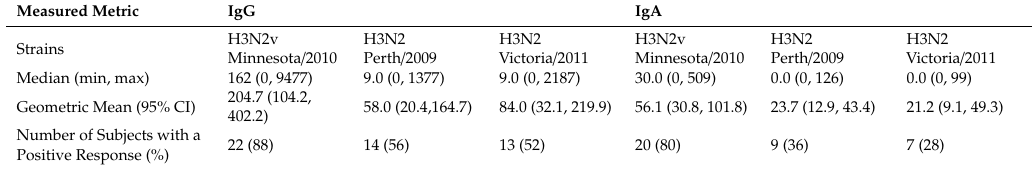
Table 3. Influenza strain-specific plasmablasts 1 per million PBMCs at Day 8 post first vaccination.